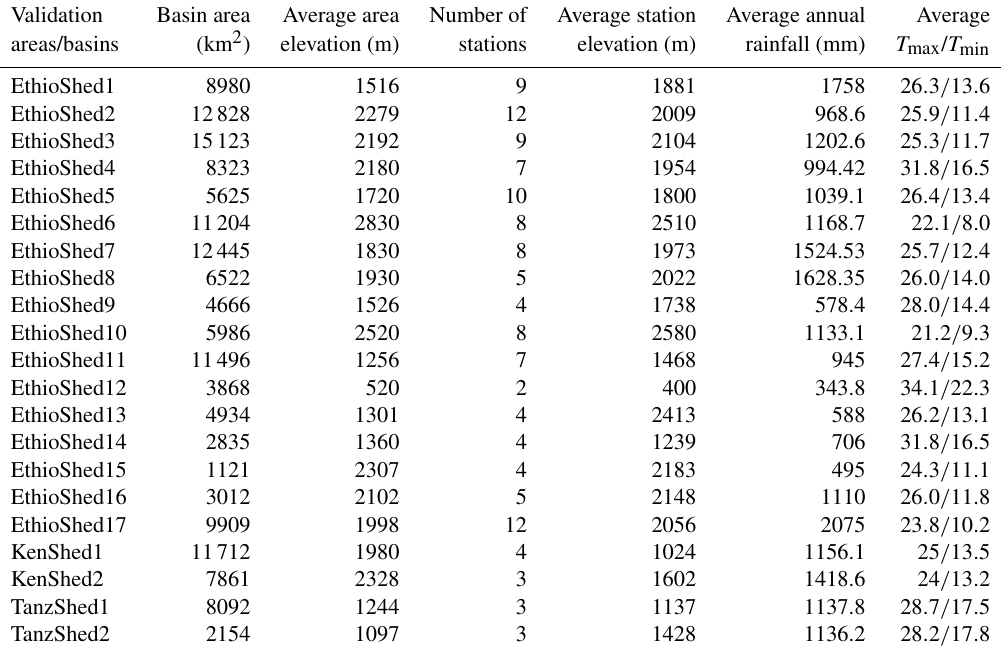
Table 1. General characteristics of selected validation areas and meteorological stations covering the time period